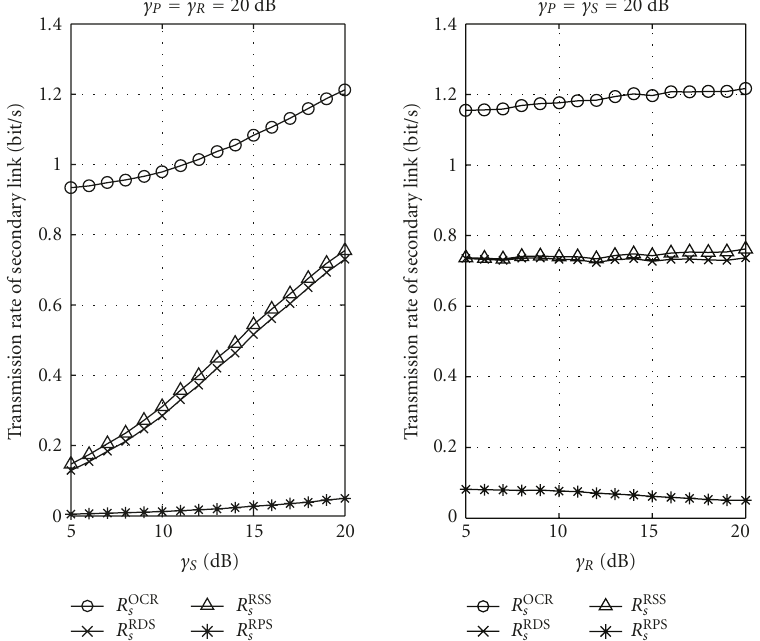
Figure 7: RPL mode selection ratio in two